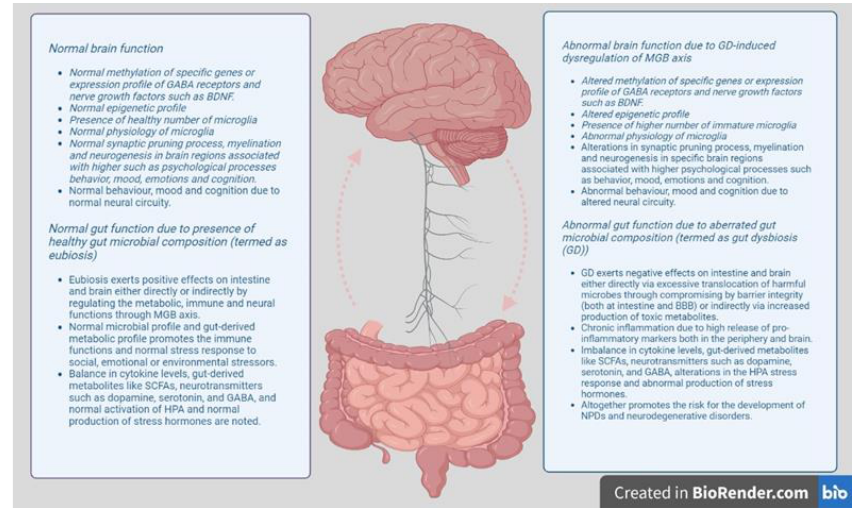
Figure 1. Gut – brain axis regulatory model. Healthy composition of gut microbiota (termed as eubiosis) maintains the integrity of the intestinal mucosa and mucus secretion, and regulates the endocrine, neural and immune signaling through the MGB axis. Healthy GM and GM-derived metabolic profiles regulate the immune function, the production of neurotransmitters and stress hormones, and maintains the function of glial cells, synaptic pruning and myelination. Thus, the MGB axis influences higher psychological functions such as mood, emotion, cognition and memory by regulating the neural circuits. Abnormal composition of gut microbiota (termed as dysbiosis) disrupts the intestinal membrane integrity and dysregulates the functions of endocrine, neural and immune system through MGB axis. Aberrated GM and GM-derived metabolic profile results in immune-driven inflammatory response, inadequate secretion of neurotransmitters, and increased stress response, immature and dysfunctional glial cells, impaired synaptic pruning, and myelination. Thus, deregulation of the MGB axis affects the higher psychological functions such as mood, emotion, cognition and memory by altered neural circuitry.